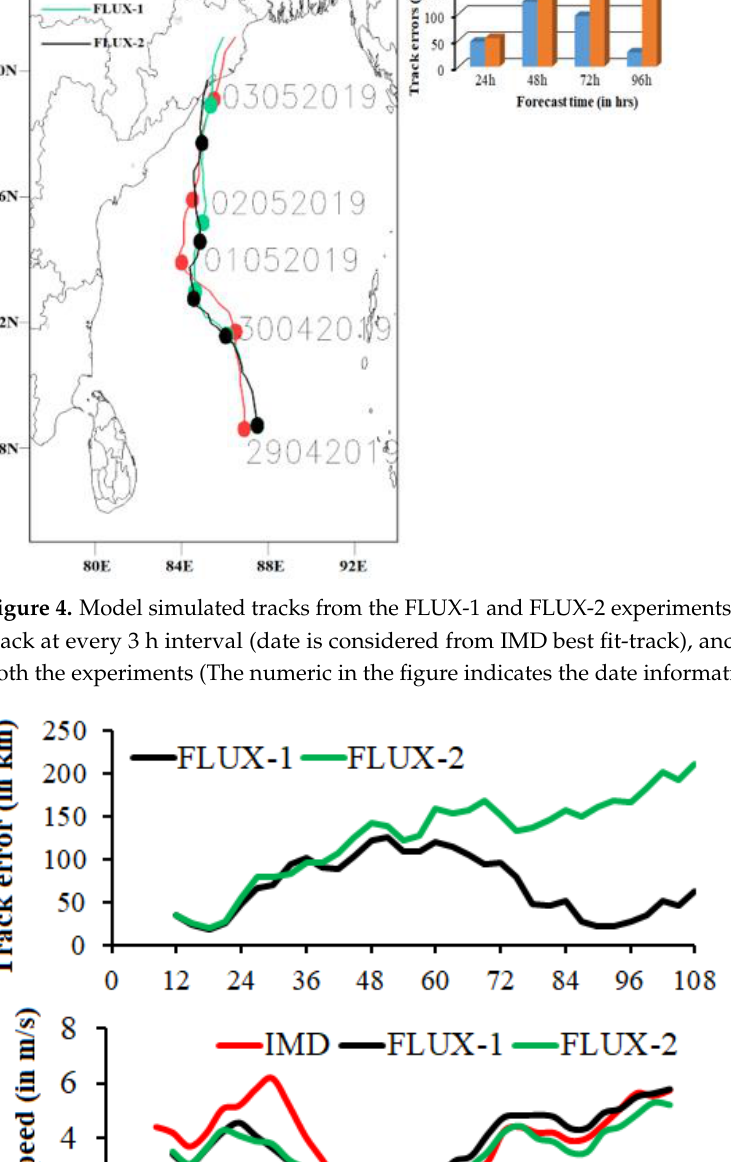
Figure 5. Model simulated track errors (in km) and translation speed (m/s) from simulations along with IMD best-fit track at every 3 h interval.